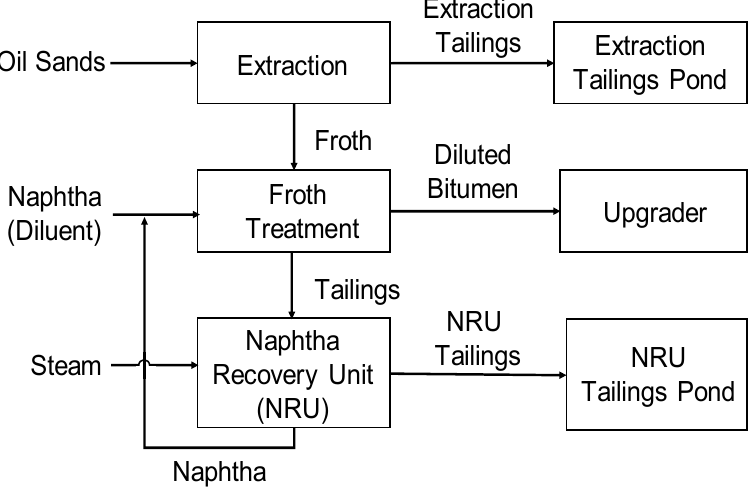
Figure 1. Simplified process flow diagram of bitumen extraction from oil sands. Processes 2017 , 5 , x FOR PEER REVIEW